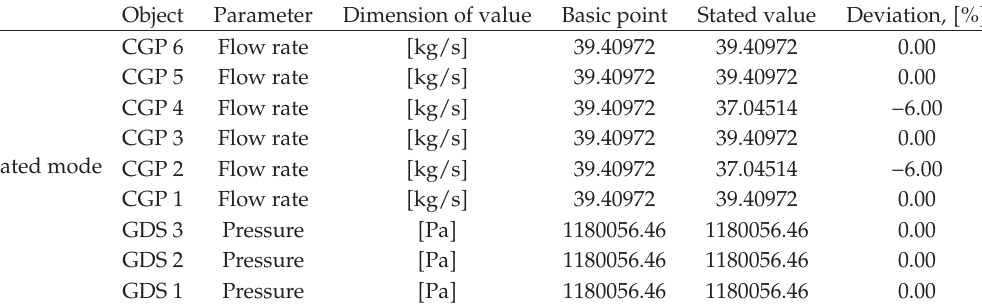
Table 10: Stated mode of natural gas supply to consumers.